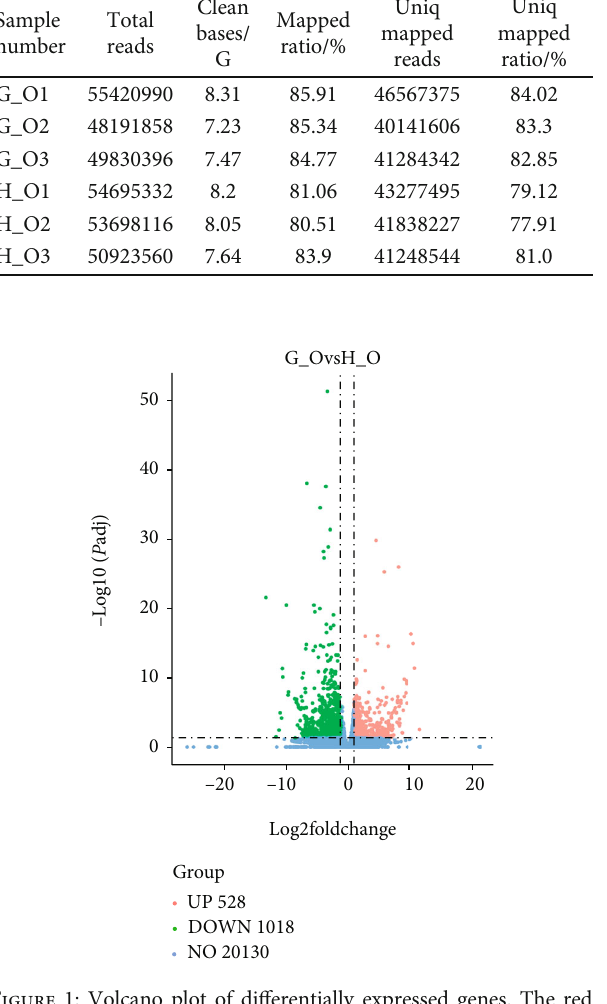
Figure 1: Volcano plot of di ff erentially expressed genes. The red dots in the volcano map indicate upregulated genes, green dots indicate downregulated genes, and blue dots indicate indi ff erent genes.